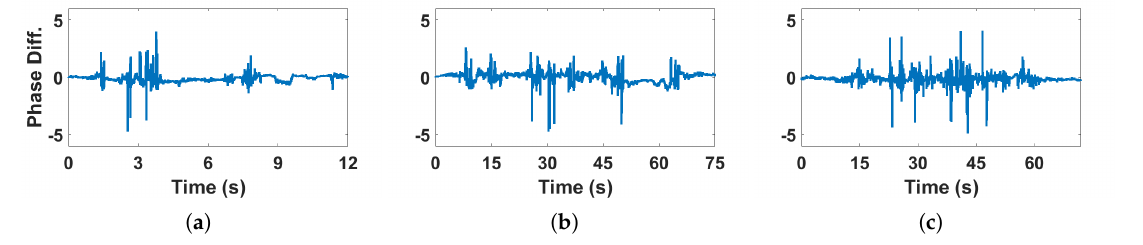
Figure 8. CSI phase difference of human motion activities under NLOS condition ( a ) One person, daily activity; ( b ) Two persons, daily activity; ( c ) Two persons, intense